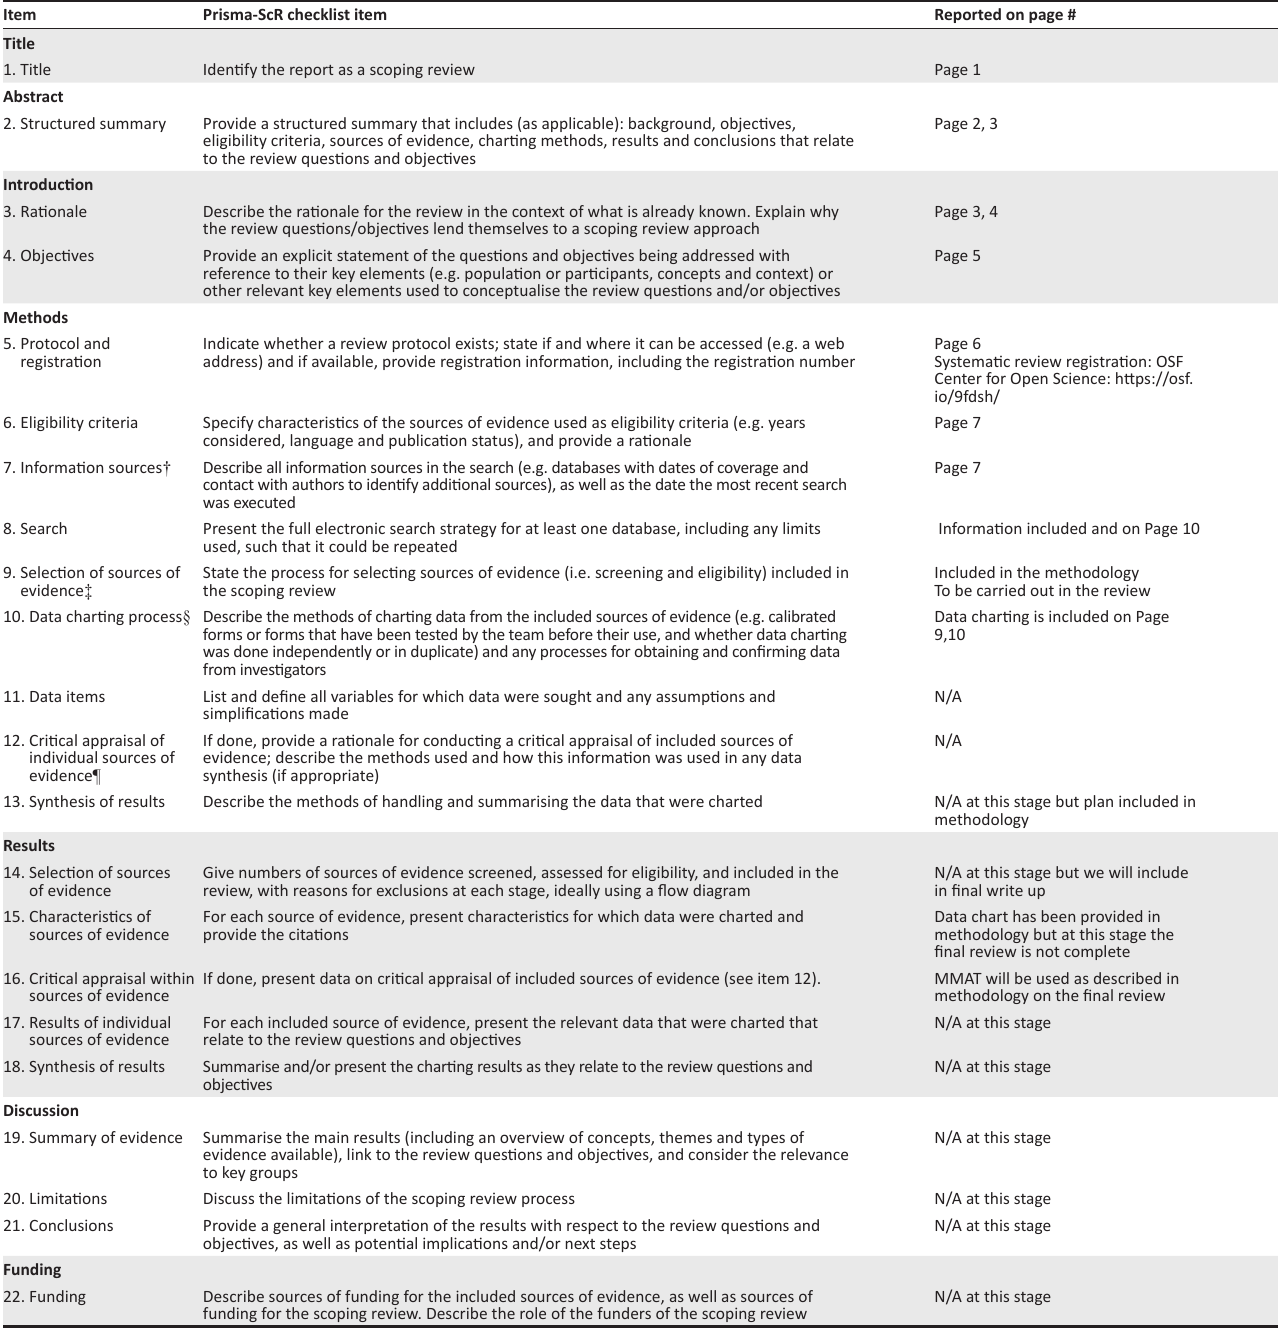
TABLE 1-A1: Preferred Reporting Items for Systematic Reviews and Meta-Analyses extension for Scoping Reviews (PRISMA-ScR)